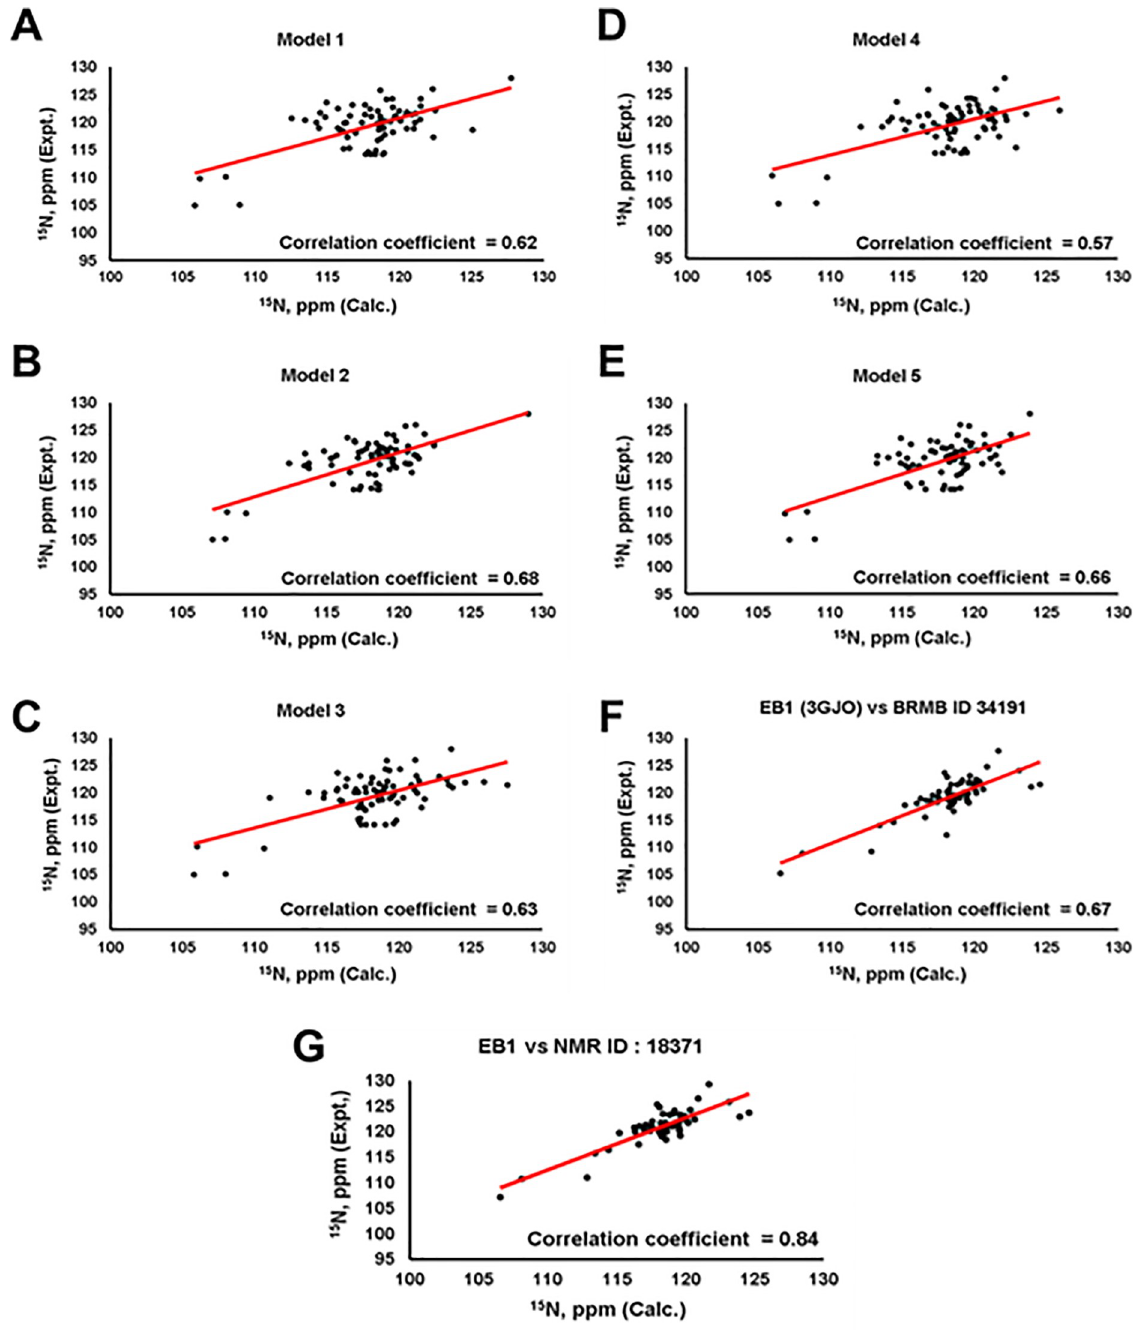
Fig 4. Validation of in silico structure predictions for the C-terminal domain of EB3 based on secondary structure and EB1 (PDB ID: 3GJO) homology restraints, using SHIFTX2. A-E ) Comparisons of experimental 15 N chemical shifts for the C-terminal domain of EB3 plotted along the Y-axis with the corresponding 15 N chemical shifts calculated by SHIFTX 2.0 plotted along the X-axis; correlation coefficients are shown for each comparison. Model 2 of the C-terminal domain of EB3 exhibits the highest correlation coefficient, which is comparable to the correlation coefficients for the X-ray structure of the C-terminal domain of EB1 determined using the two sets of 15 N chemical shift values with BMRB deposition numbers 34191 ( F ) and 18371 ( G ). Hence, Model 2 is a plausible conformation of the C-terminal domain of EB3 in